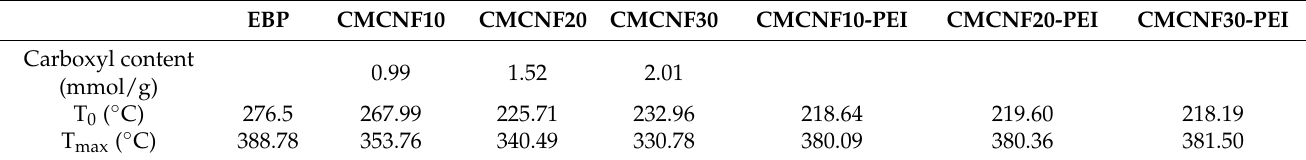
Table 1. Thermal stability parameters of EBP and CMCNFs.